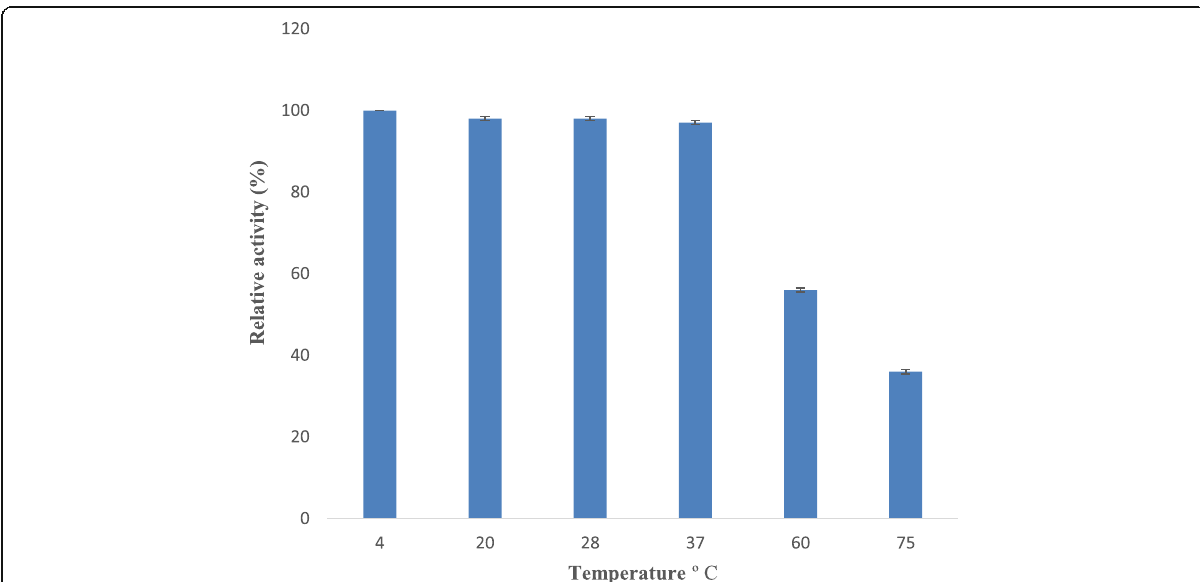
(http://myhits.isb-sib.ch/cgibin/motif_scan). Prediction of structure